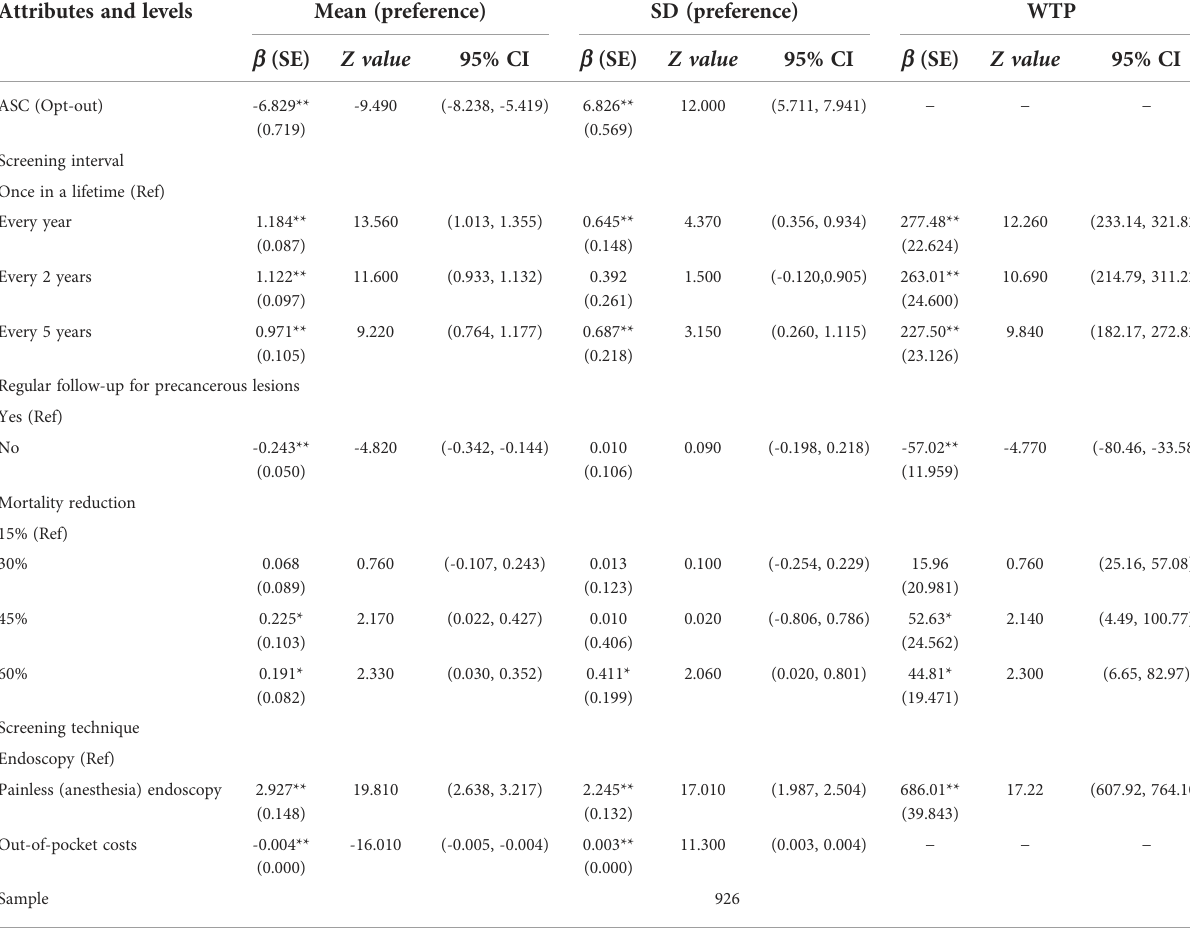
TABLE 3 Preference and WTP results of a mixed logit model. Attributes and